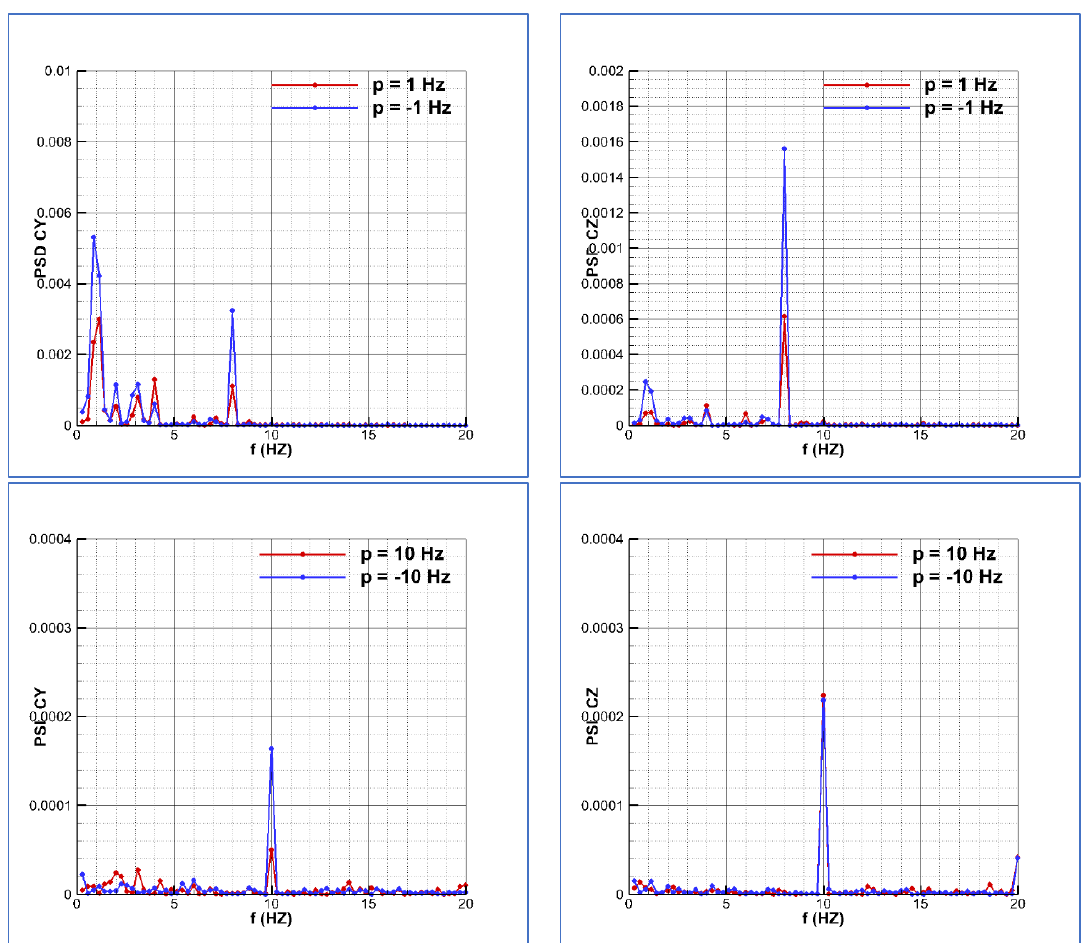
Figure 12. Power spectral analysis for the side ( left ) and normal ( right ) force coefficients. Ma = 0.2, Re =2 × 10 6 and α = 20 deg. Calculation with p = ±1 Hz ( above ) and p = ±10 Hz ( bottom ). Blue color: negative spin velocity. Red color: positive spin velocity.